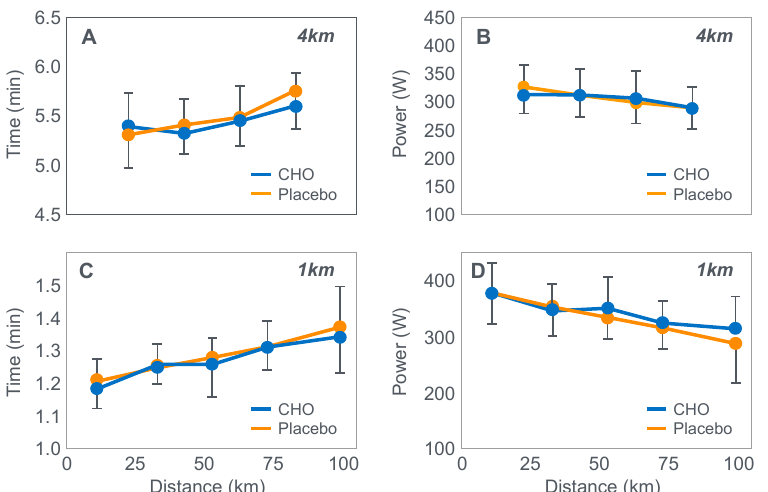
Figure 25. Times (panels A , C ) and power outputs (panels B , D ) in 4 km (panels A , B ) and 1 km sprints (panels C , D ) interspersed within a 100 km cycling time trial were not different when subjects had undergone pre-exercise ‘carbohydrate loading’ with either real carbohydrates or a placebo. Adapted with permission from ref. [120]. Copy-right 2000. American Physiological Society.